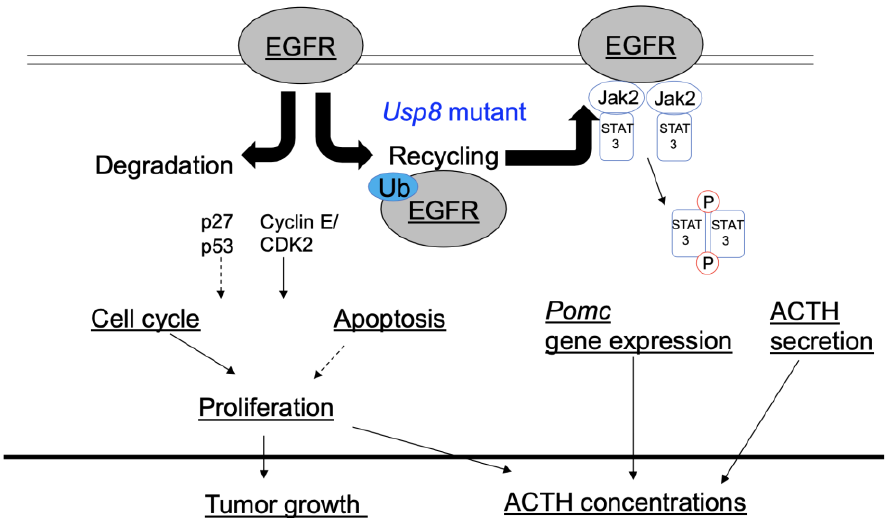
Figure 3. Proposed signaling mechanisms of the EGFR-related pathway in corticotroph tumor cells. The mutations hyperactivate ubiquitin-specific protease 8 (USP8), resulting in the inhibition of epidermal growth factor receptor (EGFR) degradation. Thus, increased EGFR stability contributes to the maintenance of EGFR signaling in Cushing’s disease. The Janus kinase/signal transducer and activator of transcription (Jak/STAT) is located downstream of EGFR signaling and is essential for EGFR-driven migration and invasion. Phosphorylated STAT3 is required for Pomc transcription. Ub; ubiquitin. HSP90